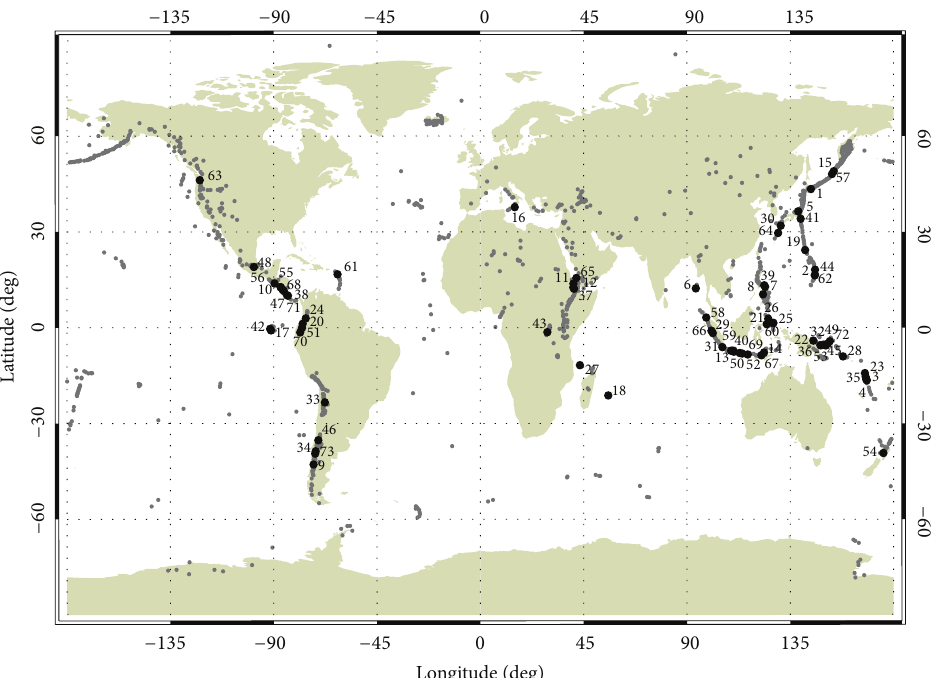
Figure 1: Location of active volcanoes. Volcanoes entering into eruption between August 2004 and December 2010 are numbered from 1 to 73.